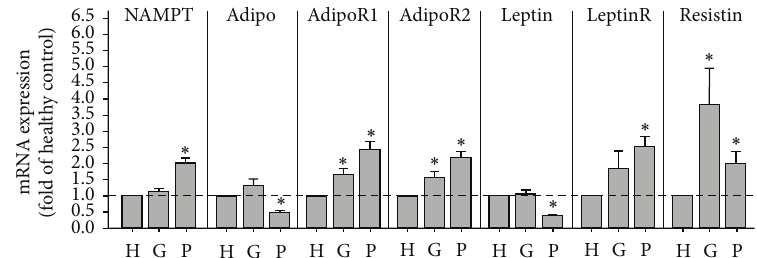
Figure 3: Expression of NAMPT and other adipokines in gingival biopsies. Expression of NAMPT, adiponectin (Adipo) and its receptors (AdipoR1 and AdipoR2), leptin and its receptor (LeptinR), and resistin in gingival biopsies from 10 periodontally healthy donors, 10 gingivitis subjects, and 10 periodontitis patients. H: healthy donors; G: gingivitis subjects; P: periodontitis patients. Mean ± SEM; ∗ significantly ( 𝑃 < 0.05 ) different from periodontally healthy